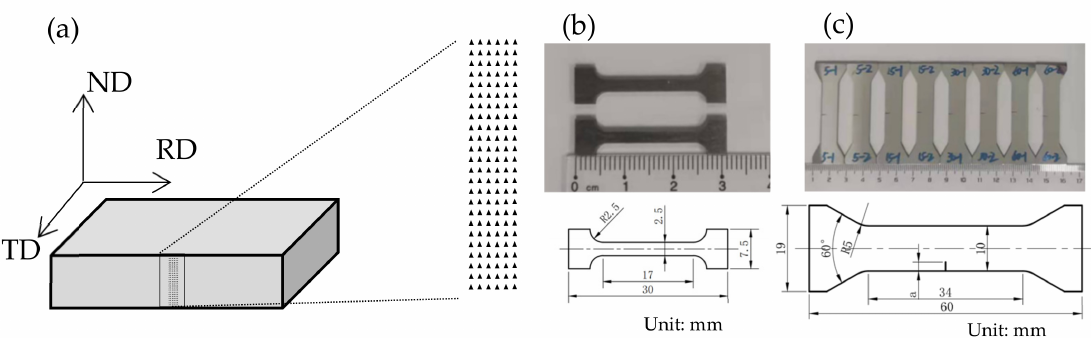
Figure 1. Diagram of the specimens for microstructure characterization and mechanical testing. ( a ) Section for EBSD and nanoindent measurements. ( b ) Tensile specimens. ( c ) Single edge crack tension (SET) specimens for fatigue crack propagation